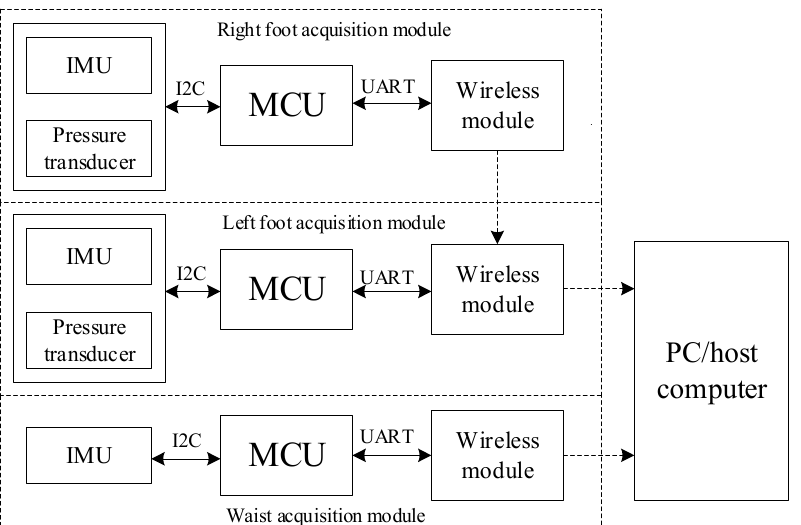
Figure 1. Information collection system (MPU9250 is used as IMU, MD30-60 is used as plantar pressure sensor and STM32F103VET6 is used as MCU).